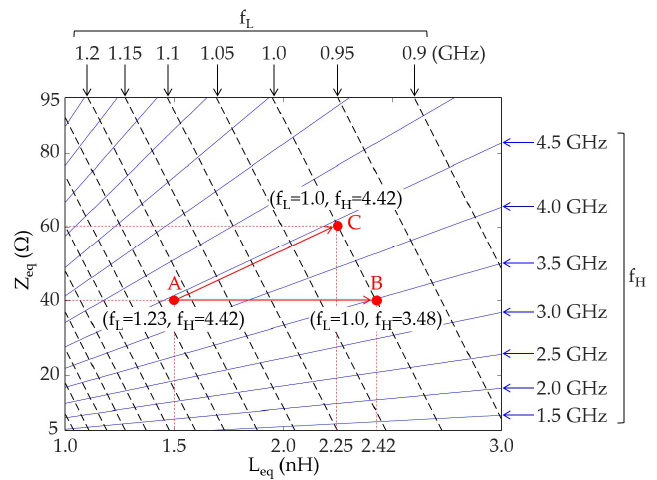
Figure 5. Contour plots of f L and f H used for the design and analyses of DP–EBG structures.